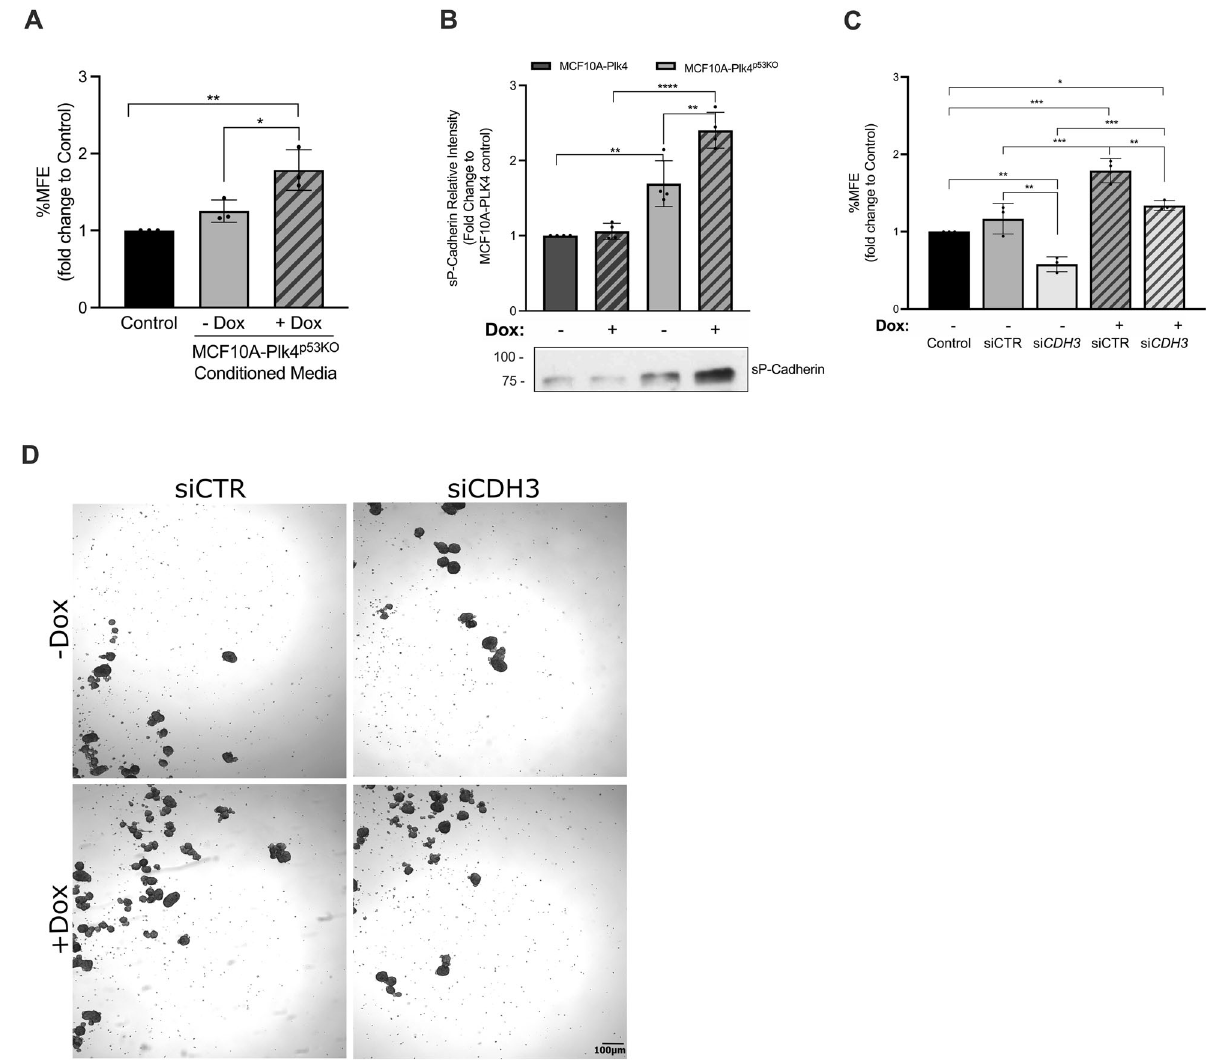
Fig. 5 Soluble P-Cadherin (sP-cad) is partially required for anoikis resistance of breast cancer cells mediated through the conditioned media of p53KO cells with centrosome ampli fi cation. A MFE assay of BT20 breast cancer cells under the following conditions: (control) nontreated; (Dox-) treated with conditioned media from MCF10A-Plk4 p53KO without Plk4 OE; (Dox + ) treated with conditioned media from MCF10A-Plk4 p53KO with Plk4 OE. There is a signi fi cantly increase MFE when BT20 cells were treated with the conditioned media of MCF10A- Plk4 p53KO with induced Plk4 overexpression. All conditions were normalized to the control condition (BT20 control). Data shown is average ± SD for three independent experiments, p < 0.05, Ordinary One-Way ANOVA. B Western blot analysis of conditioned media from MCF10A-Plk4 and p53KO cell line showing different expression levels of sP-cad. P-cadherin ectodomain cleaved (sP-cad) expression is increased in p53KO cells treated with Dox. MCF10A-Plk4 cells have lower P-cadherin basal levels, which is not affected by Plk4 overexpression. Data shown are average ± SD for four independent experiments, p < 0.05, Ordinary One-Way ANOVA. C MFE assay of BT20 breast cancer cells incubated with the following conditioned media: (Control) no treatment; (siCTR; Dox-) MCF10A-PLK4 p53KO -siCTR without Plk4 OE; (siCDH3; Dox + ) MCF10A- Plk4 p53KO depleted of P-cadherin without Plk4 OE; (siCTR; Dox + ) MCF10A-Plk4 p53KO -siCTR with Plk4 OE; (siCDH3; Dox + ) MCF10A-Plk4 p53KO depleted of P-cadherin with Plk4 OE. P-cadherin-silencing signi fi cantly affects mammosphere forming capacity. Data shown is average ±